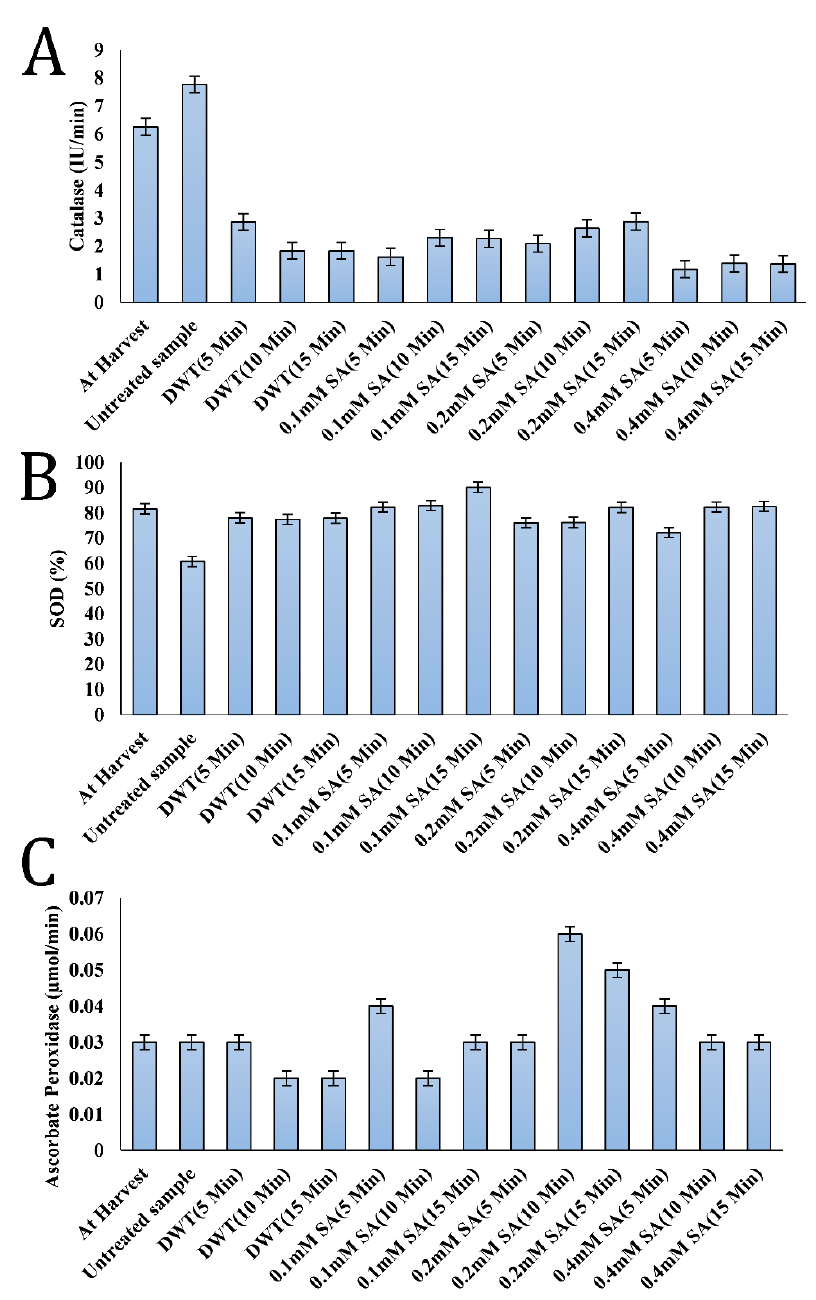
Figure 2. Salicylic acid (SA) treatment effect on catalase (CAT) (A), superoxide dismutase (SOD) (B), and ascorbate peroxidase (APX) (C) activities in African star apple ( Chrysophyllum albidum ) fruits after 15 days of storage at 28±2 °C and relative humidity of 90±5% for 15 days. Bars represent the mean ± standard error. DWT: Distilled water-treated